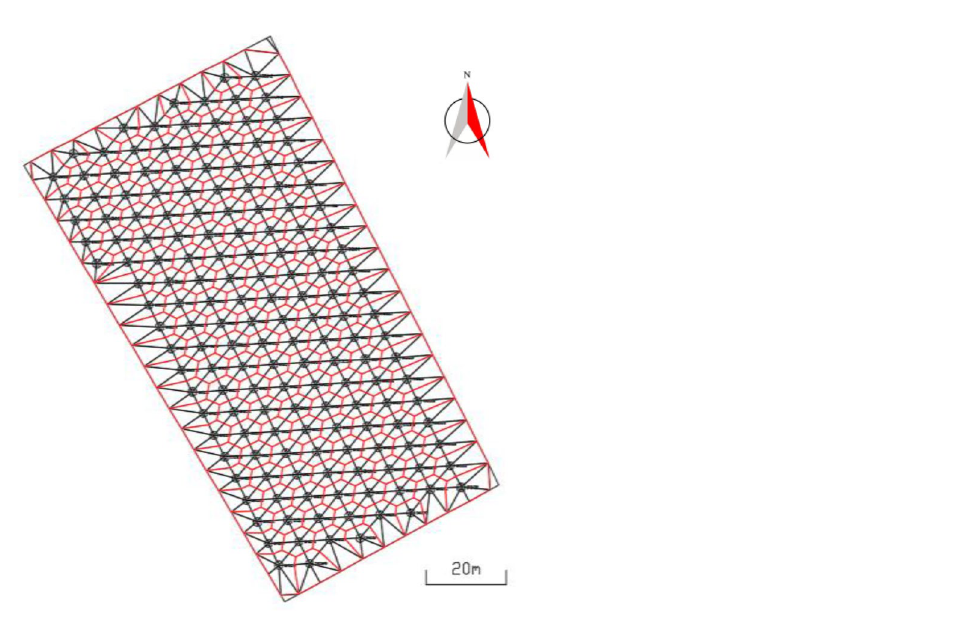
Figure 11. Influence range of blast